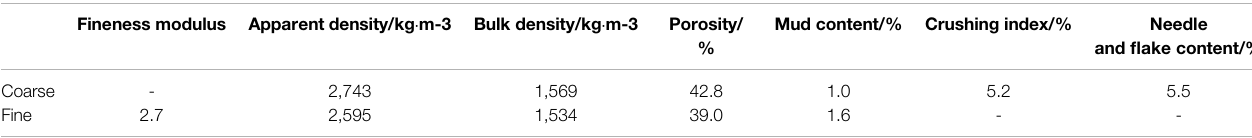
TABLE 4 | Technical indexes of coarse and aggregate.